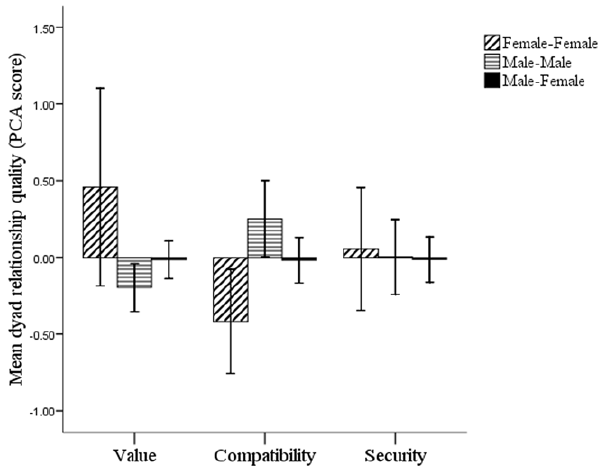
Figure 2. Histogram showing the mean relationship quality (PCA component scores) of female-female, male-male and female-male dyads.